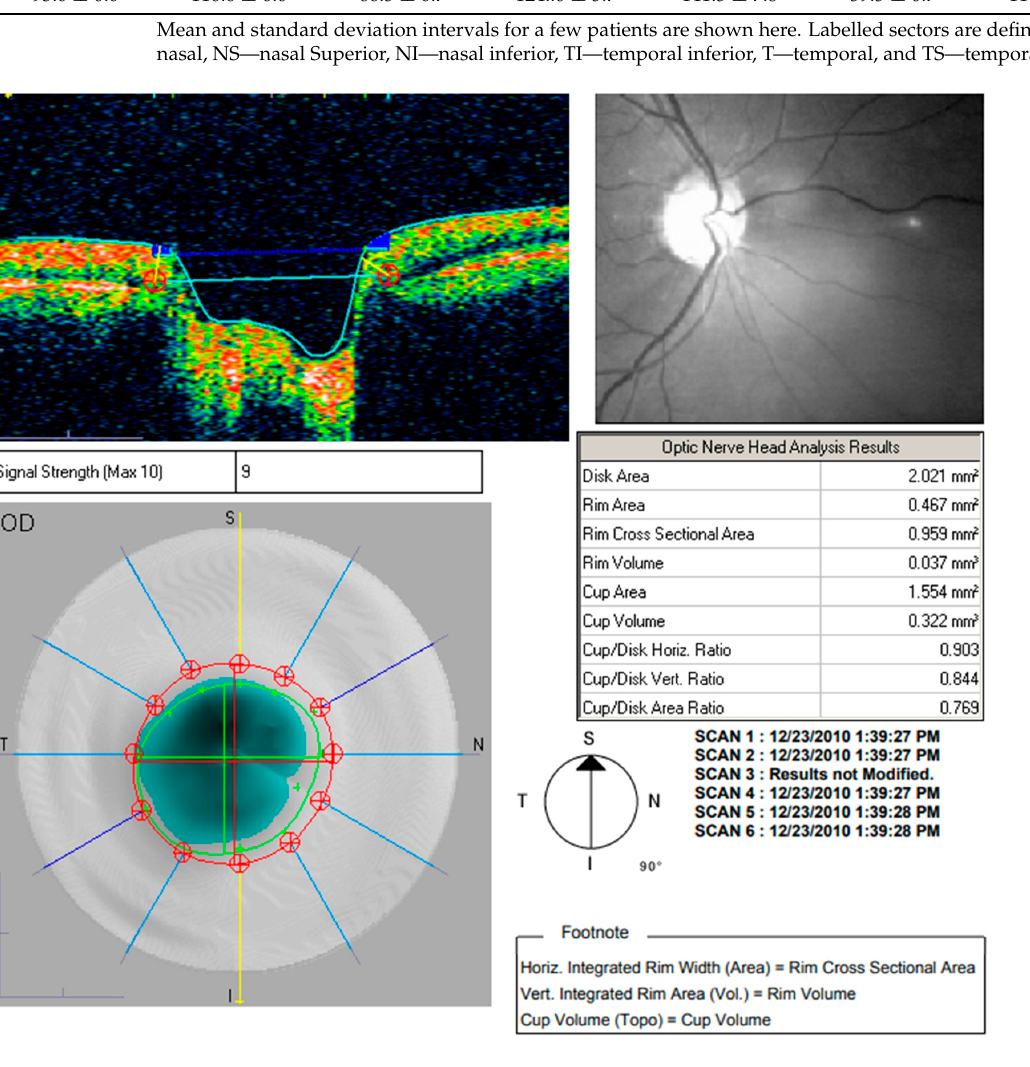
Figure 3. Optic nerve head analysis using Optic Disc.